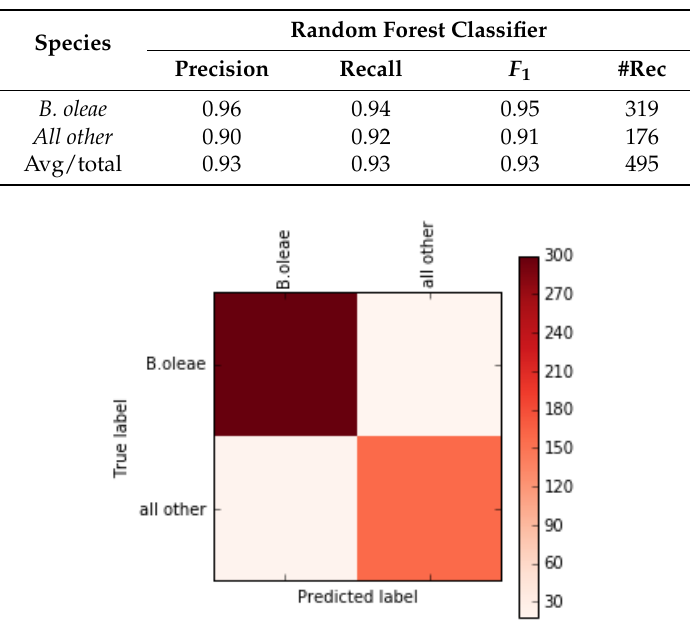
Table 4. Different accuracy metrics using a 20% hold out set.